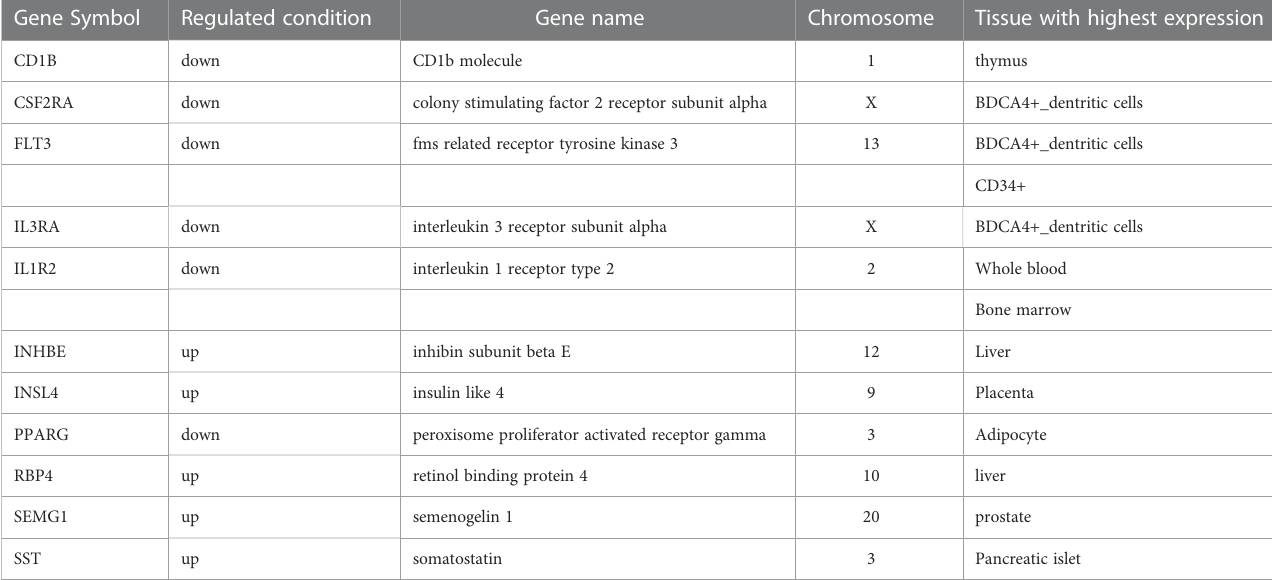
TABLE 1 The tissue-speci fi c genes in Xm TS patients. Gene